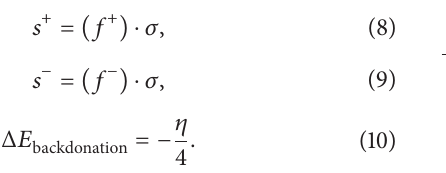
Table 1: Corrosion parameters for zinc in 0.5M HCl in the absence and presence of various concentrations of Schiff bases at 35 ± 0.5 ∘